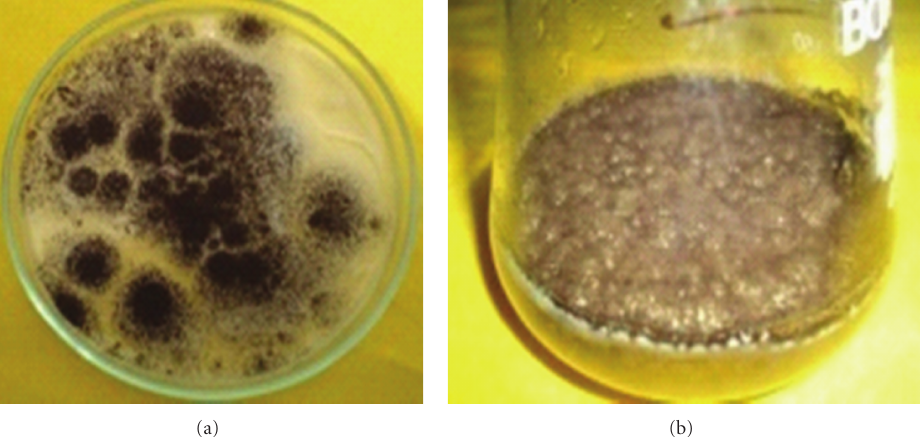
Figure 1: The cultures of Aspergillus niger : (a) solid medium on Czapek dox agar (CDA), (b) liquid medium Czapek dox broth maintained in the